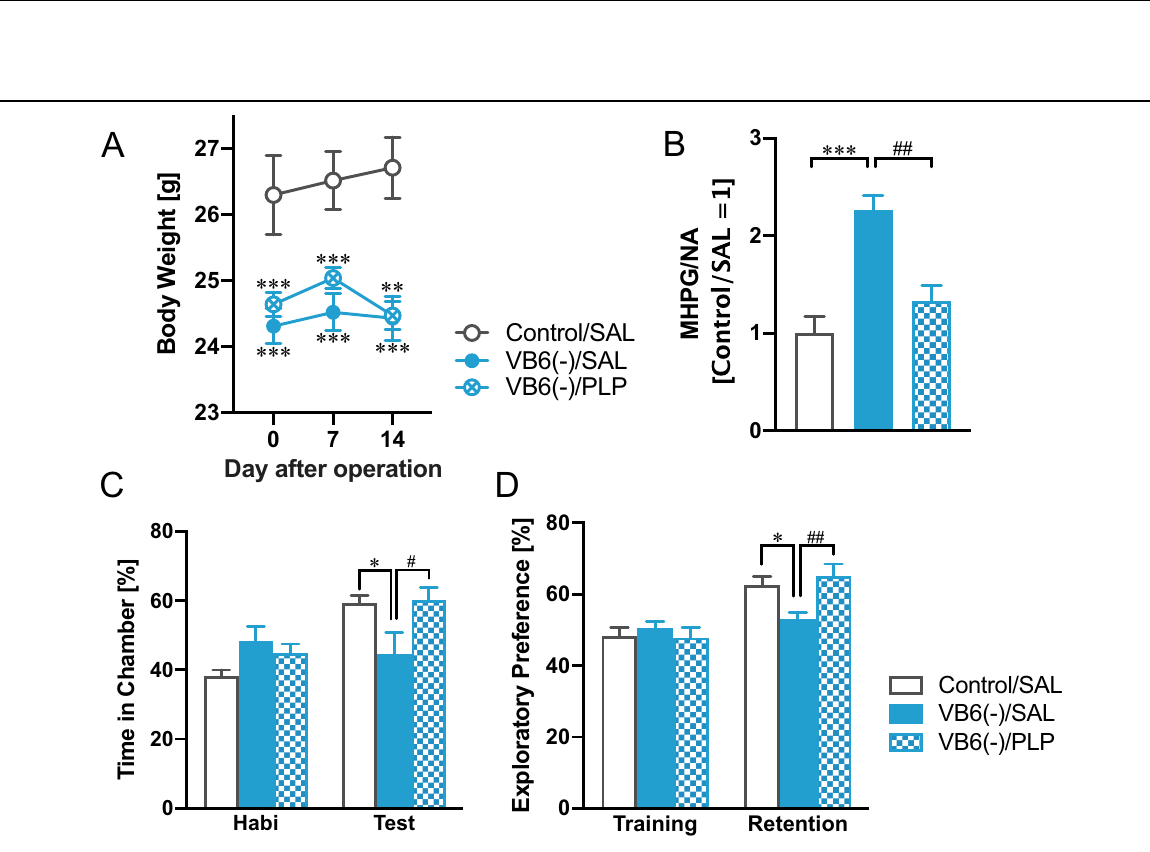
Fig. 4 Rescue of behavioral de fi cits in VB6-de fi cient mice by PLP supplementation into the brain. A Changes in body weight after the implantation of osmotic pump are shown (Two-way ANOVA with repeated measures: F Interaction(4,50) = 2.38, p > 0.05; F Day(2,50) = 3.31, p < 0.05; F Group = 11.6, p < 0.05. B NA turnover in the PFC were determined by HPLC. One-way ANOVA: F = 15.7, p < 0.001. C Exploratory preference in the (2,25) (2,25) novel object recognition test and D time spent in the chamber in the social interaction test were measured. Two-way ANOVA: C F Interaction(2,25) = 6.10, p < 0.01; F Session(1,25) = 38.0, p < 0.001; F Group(2,25) = 1.67, p > 0.05, D F Interaction(2,25) = 7.67, p < 0.01; F Session(1,25) = 16.5, p < 0.001; F Group(2,25) = 1.16, p > 0.05. * p < 0.05, **p < 0.01, ***p < 0.001 (vs. control/SAL) and # p < 0.05, ## p < 0.01 (vs. VB6( − )/SAL) using Bonferroni ’ s multiple comparison test ( n = 9 – 10). The data were shown as mean ± SEM